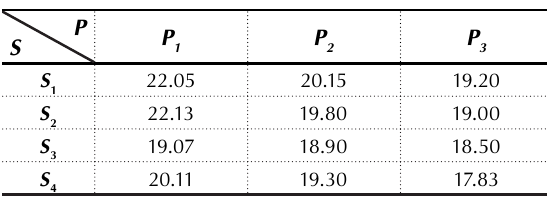
Table 5. DPP – discounted payback period